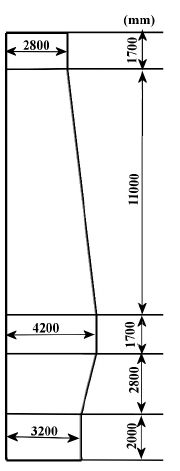
Figure 1. Schematic diagram of the Blast Furnace (BF) and its size (mm). Table 1. Normal operation conditions of BF.